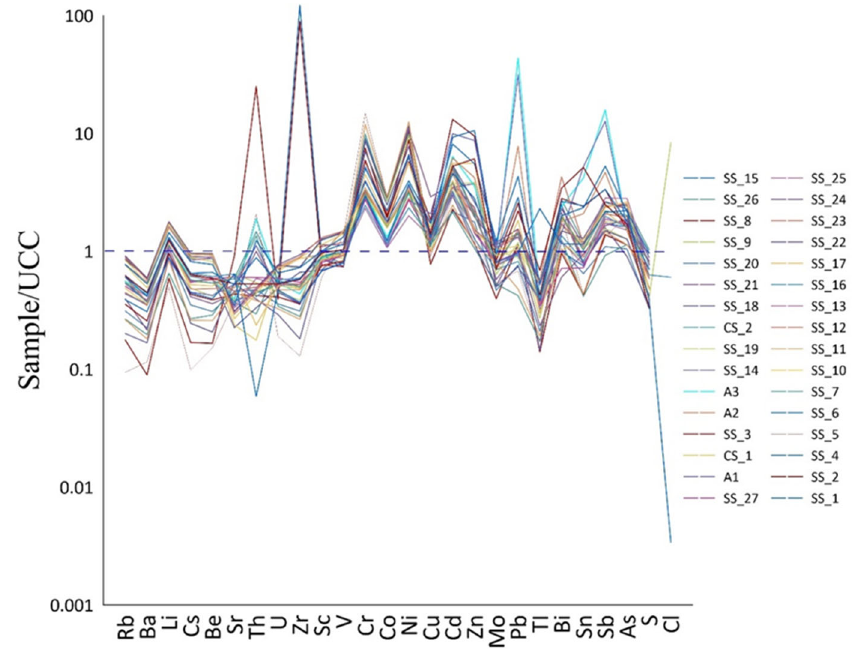
Figure 5. Upper ‐ Continental Crust (UCC) normalized trace elements diagram for the studied sam ‐ Figure 5. Upper-Continental Crust (UCC) normalized trace elements diagram for the studied ples.